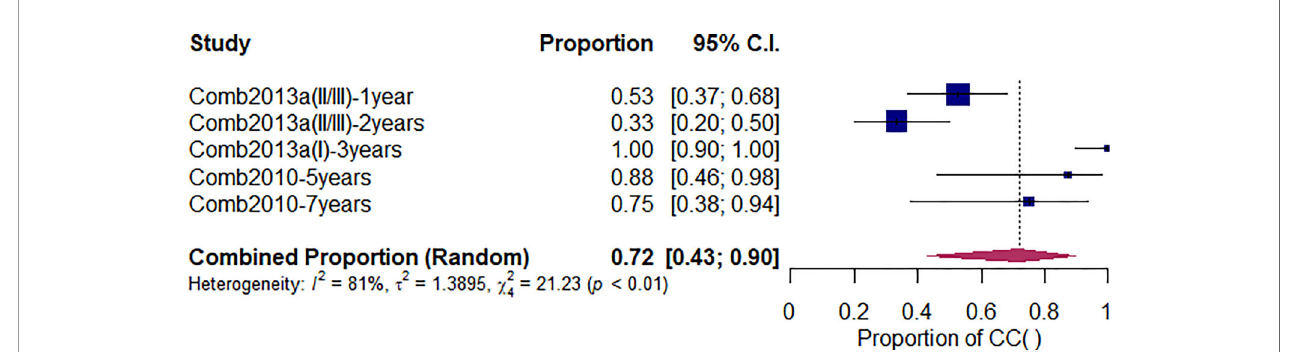
FIGURE 3 | The local control rate of meningioma initial diagnosis treated with